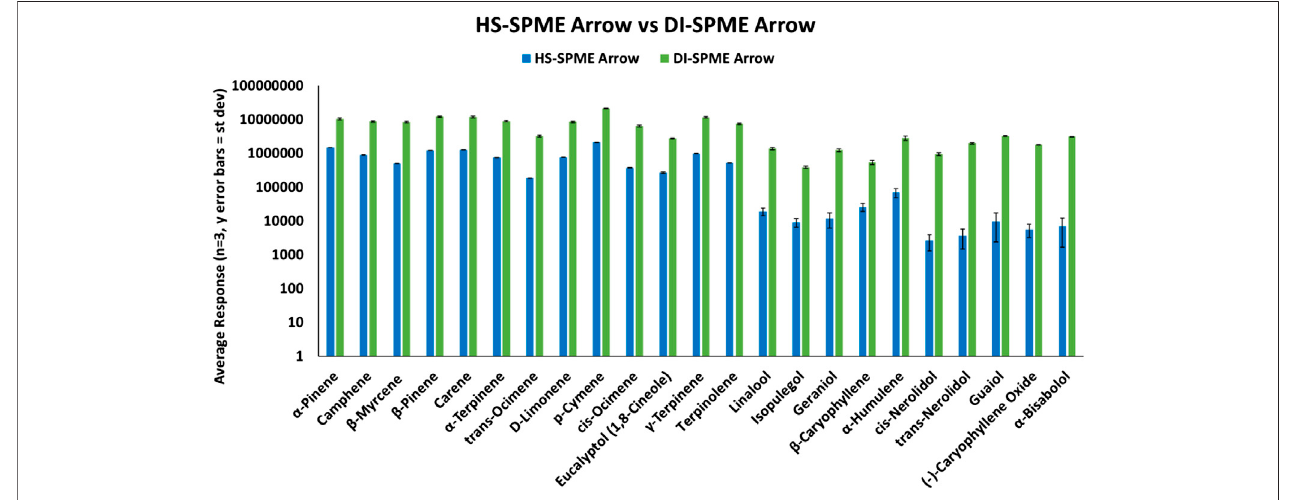
FIGURE 2 | HS-SPME Arrow vs DI-SPME Arrow for terpenes.